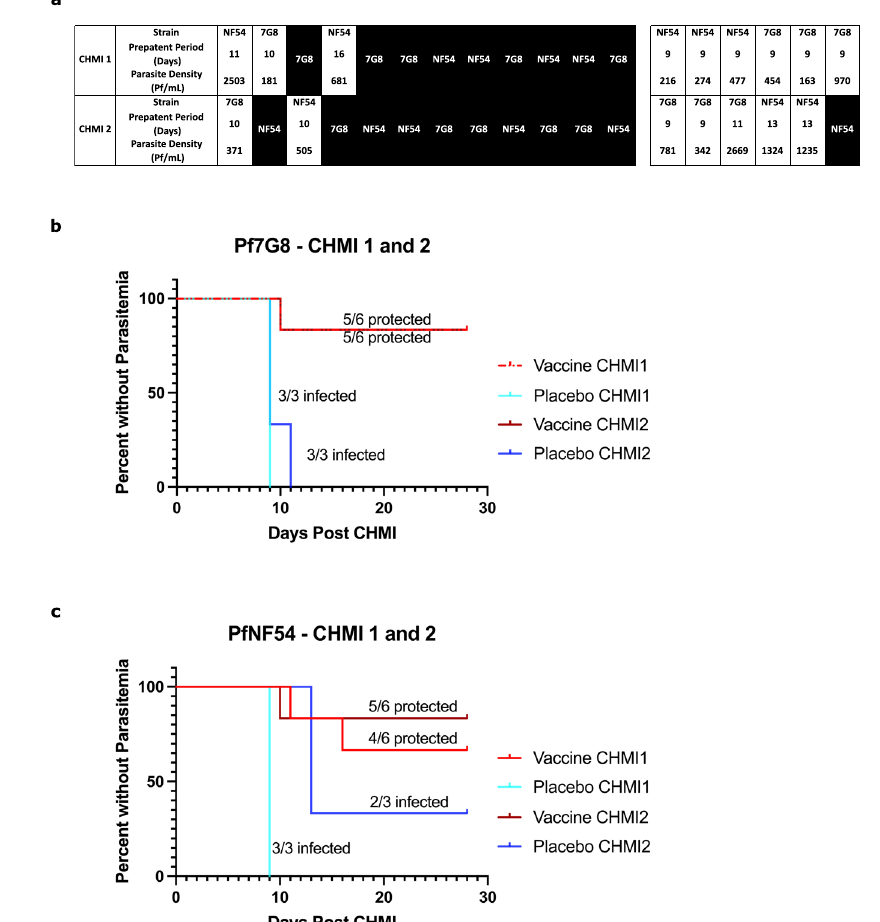
Fig. 2 Results of CHMIs to assess VE during Veri fi cation . a First CHMI at 3 weeks (top row) and second CHMI at 9 – 10 weeks (bottom row) of the individual volunteers. The black indicates no parasitemia (protected); the white represents parasitaemia (not protected). b Kaplan-Meier plots for heterologous CHMIs with Pf7G8. Five of 6 vaccinees were protected at 3 weeks and at 9 – 10 weeks. Six of 6 CHMIs with PfSPZ Challenge (7G8) in the controls resulted in parasitemia (infected). c Kaplan-Meier plots for homologous CHMIs with PfNF54. Four of 6 vaccinees were protected at 3 weeks and 5/6 were protected at 9 – 10 weeks. Five of 6 CHMIs with PfSPZ Challenge (NF54) in the controls resulted in parasitemia (infected).